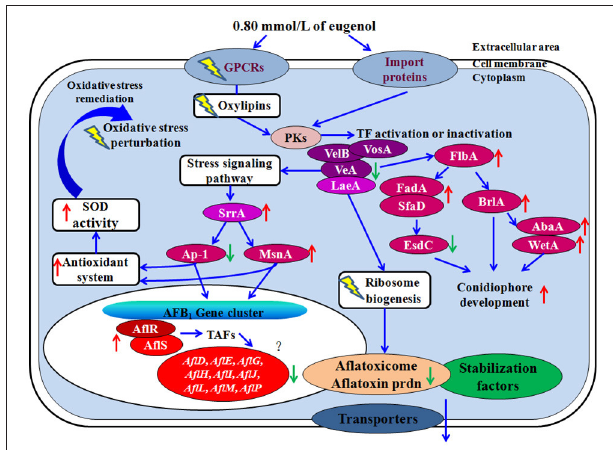
FIGURE 3 | Hypothetical mechanism of action of eugenol. Eugenol perturbs cellular signaling pathway by modulating GPCRs and oxylipins expression levels. Simultaneously, decreased levels of veA might make fungus less tolerant to oxidative stress response which could trigger an activation of several genes involved in the stress signaling pathway such as stress response transcription factor srrA , C 2 H 2 transcription factor msnA , and down-regulate bZIP transcription factor ap-1 . Final targets of these modulators correspond to fugal antioxidant system consisting in genes coding for catalasess and superoxide dismutase defenses. The down regulation of genes belonging to the AFB 1 cluster may then be a final sequence of the repressive modulation caused by the over expression of OSR transcription factors. Dysregulation of ribosome biogenesis prevents the biosynthesis of Nor-1, Ver-1, and OmtA, and the aflatoxisomes from performing their normal function in aflatoxin formation. For conidiophores development, the growth signaling from the activated fadA and sfaD should be improved by flbA . Upon the activation of them, flbA causes asexual development by the activation of the brlA gene and repression of esdC gene. Up- or down-regulation of gene upon eugenol addition is represented by red and green arrow. PKs, protein kenase; TF, transcription